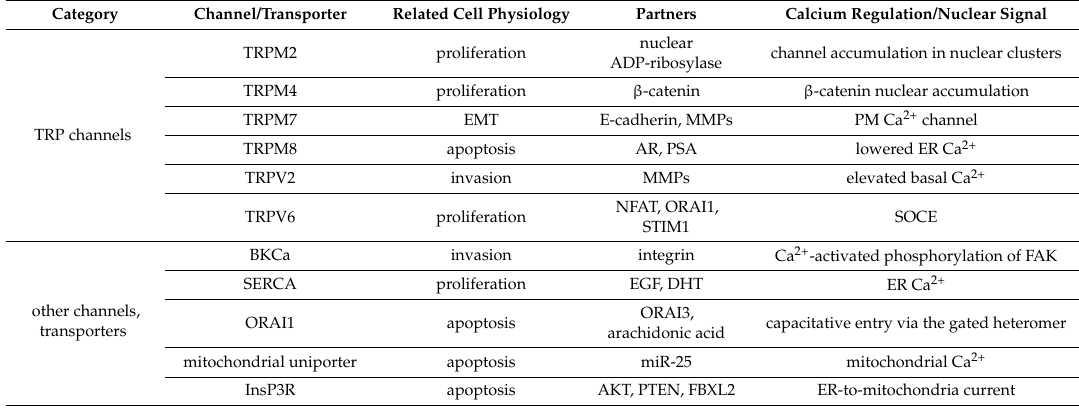
Table 2. Calcium and nuclear signaling in prostate cancer that is associated with specific channels and